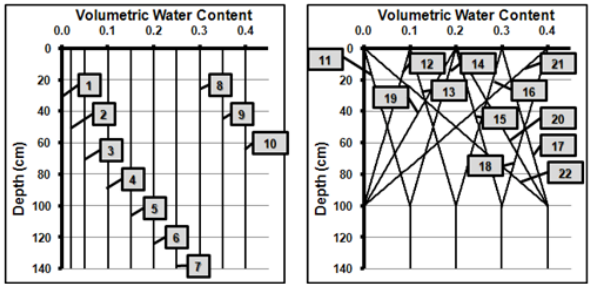
Fig. 4. The 22 prescribed profiles of soil water content (10 uniform and 12 with constant gradients) for which calculations of the above ground fast neutron count in the COSMOS detector are made using both MCNPX and COSMIC during parameter estimation.